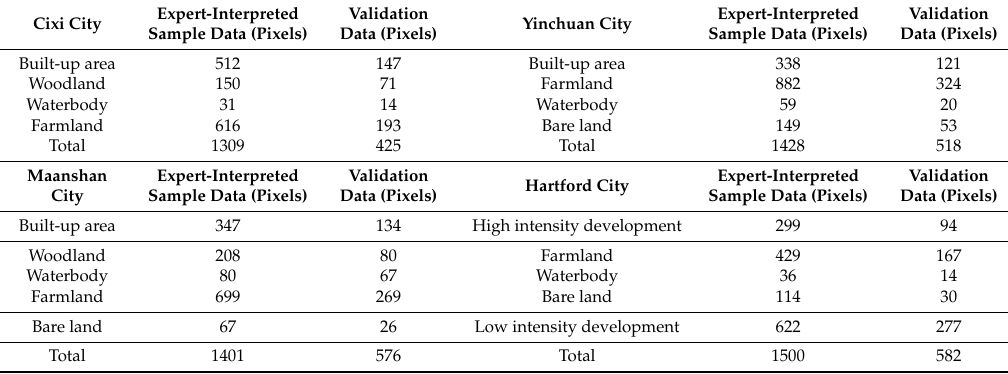
Table 1. Quantities of expert-interpreted sample datasets and validation data sets for the four case